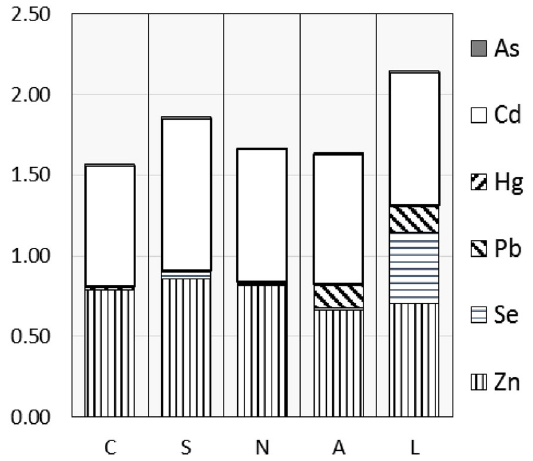
Fig. 4 Sum of extraction yield of As, Cd, Hg, Pb, Se and Zn in the five